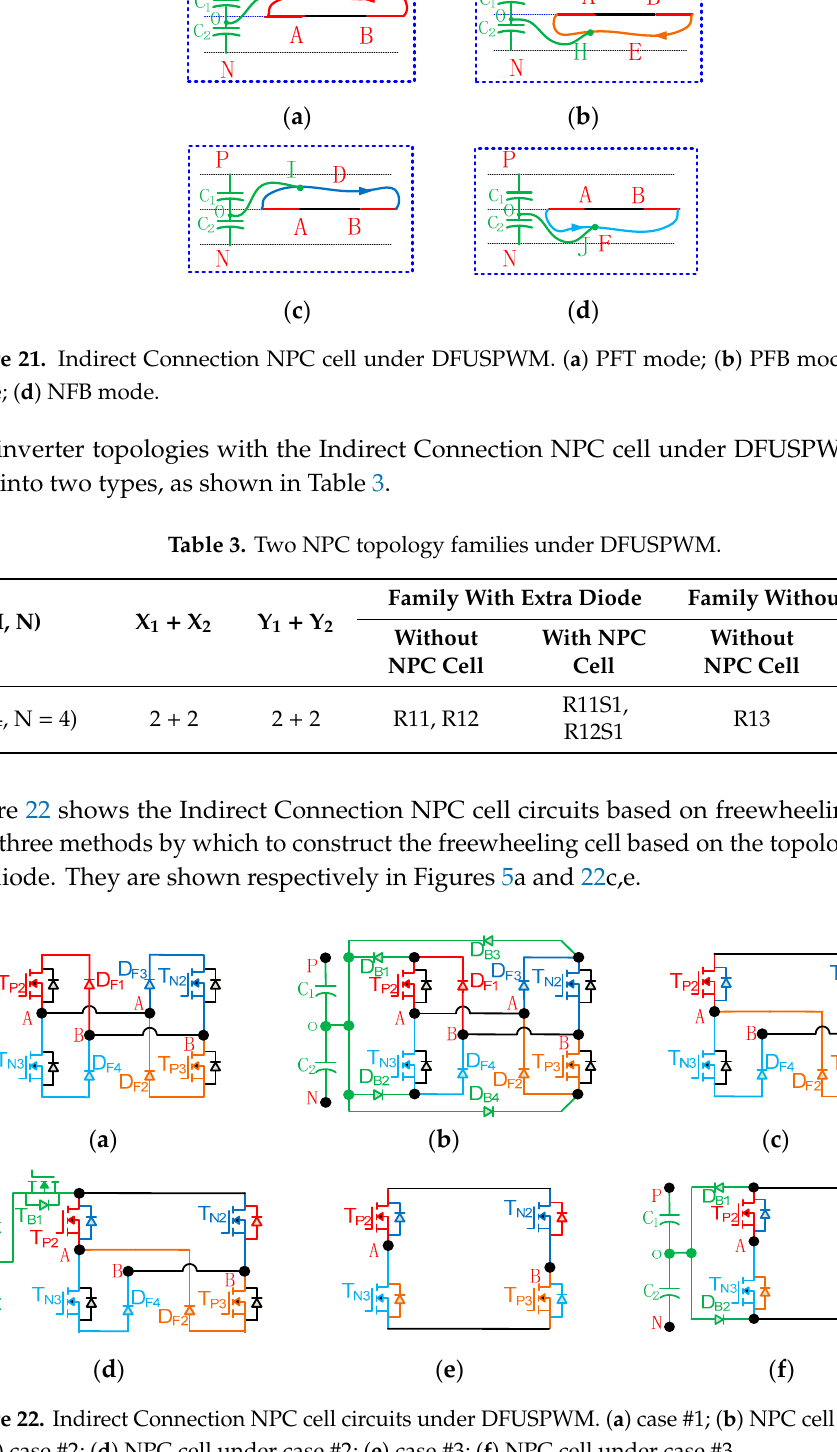
( c ) Figure 23. Inverter topologies with the Direct Connection NPC cell under DFUSPWM. ( a ) R11S1 (new); ( b ) R12S1 (new); ( c ) R13S1 (new). 5.2. Principle of the Direct Connection NPC Cell and Reflected Topology under DFUSPWM Figure 24 shows a schematic diagram of the second type of unified NPC cell under DFUSPWM. The extra branch GH(cid:3554) is injected into the freewheeling path BCA(cid:3554) in Figure 24a, and IJ(cid:3553) is injected into the freewheeling path BEA (cid:3555) in Figure 24b. Similarly, the extra branch KL (cid:3554) is injected into the freewheeling path ADB(cid:3555) in Figure 24c and MN(cid:3554) is injected into the freewheeling path AFB(cid:3554) in Figure 24d. Clearly, the internal connections of the freewheeling cell have been changed due to the injection of the Direct Connection NPC cell. ( d ) Figure 24. Direct Connection NPC cell under DFUSPWM. ( a ) PFT mode; ( b ) PFB mode; ( c ) NFT mode; ( d ) NFB mode. The inverter topologies with the Direct Connection NPC cell under DFUSPWM can also be classified into two types, as shown in Table 4.